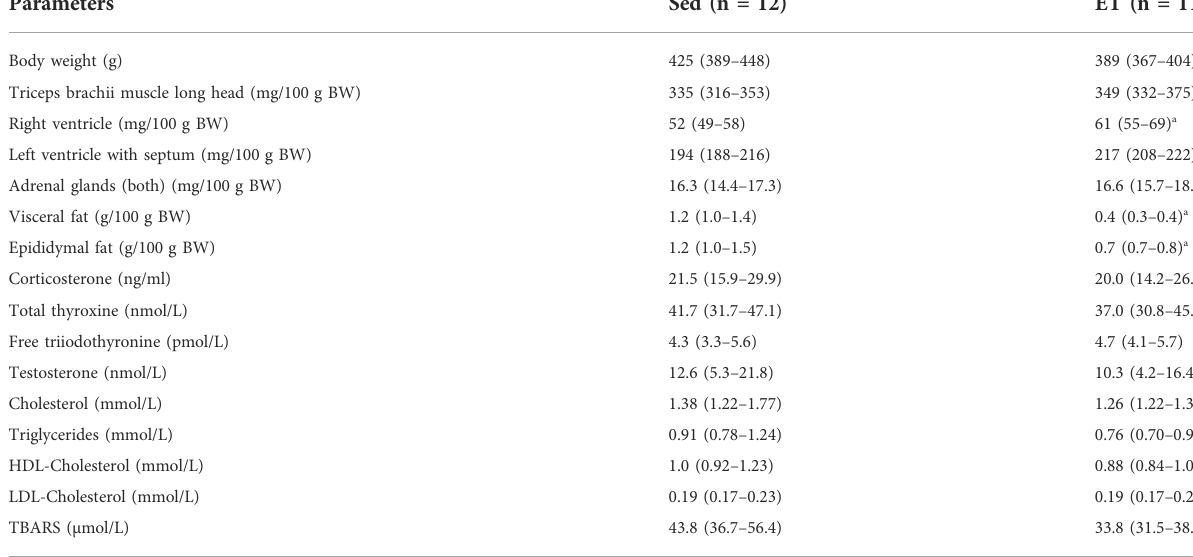
TABLE 1 Body weight (BW), relative organ weights and blood serum levels of hormones, substrates and thiobarbituric acid reactive substances (TBARS) in sedentary (Sed) and voluntary exercise-trained (ET) rats.